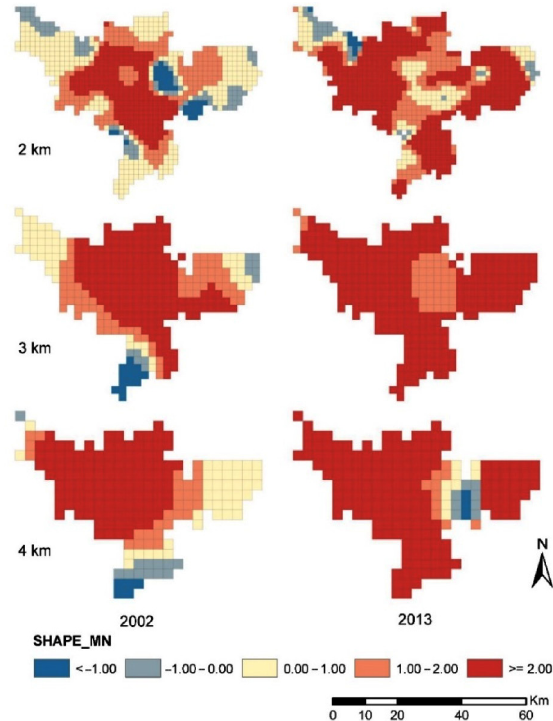
Figure 7. Spatial distributions of the correlation coefficients obtained from GWR for SHAPE_MN at three scales (2 km, 3 km, and 4